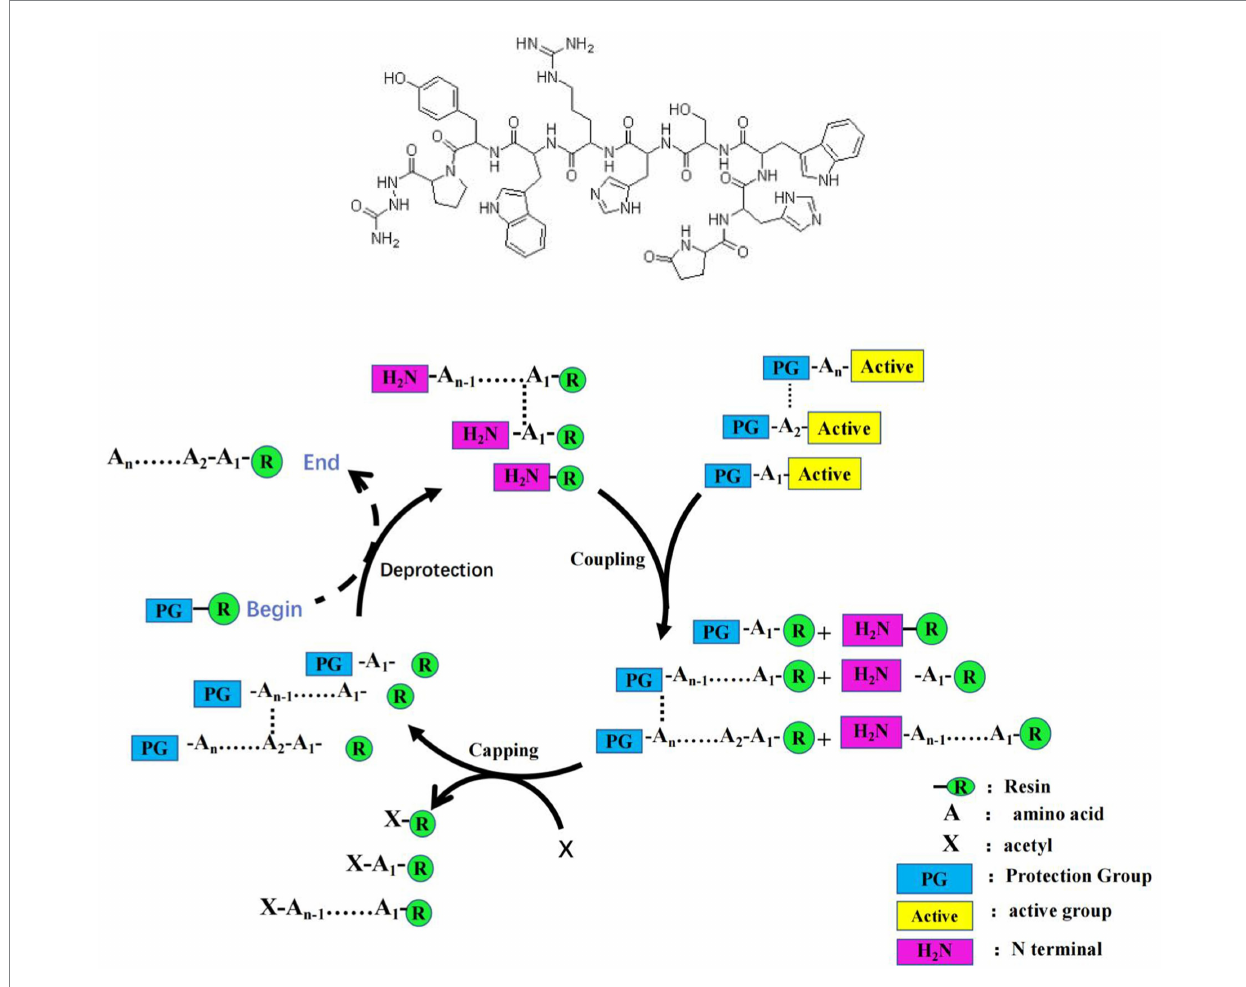
FIGURE 1 The structure of GnRH (upper) and its synthesis method